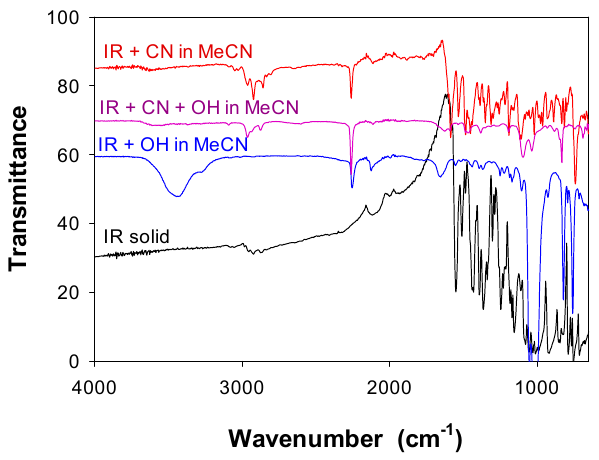
Figure 6. FT-IR spectra of IR-786 dye in different forms: solid as purchased, in MeCN and with CN − alone, in MeCN and with OH − alone and in MeCN and with OH − and CN − . The 1 H-NMR spectrum of IR-786-(CN) indicates the presence of eight aromatic protons ( δ H : 8.39, 7.53, 7.46, 7.40, 7.11, 7.07, 6.85 and 6.74), four CH protons ( δ H : 6.52, 6.21, 5.90 and 5.49 as doublet), six